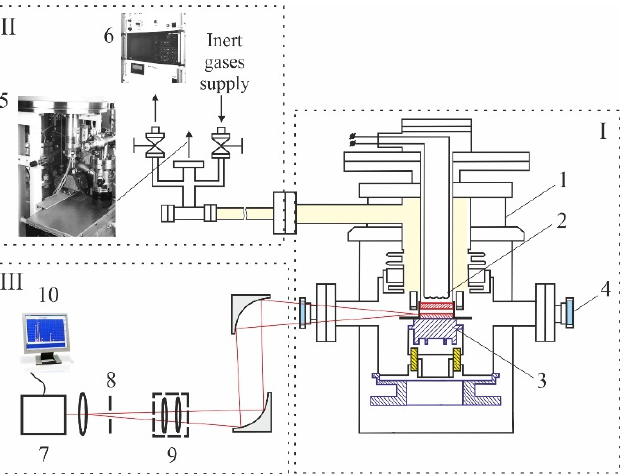
Figure 1. Principal layout of the experimental set-up: vacuum chamber unit ( I ),vacuum system ( II ), optical system ( III ), vacuum chamber (1), cathode unit (2), anode unit (3), sapphire window (4), turbomolecular pump (5), mass-spectrometry analysis system (6), monochromator (7), diaphragm (8), condenser lens (9), and experimental data processing system (10).